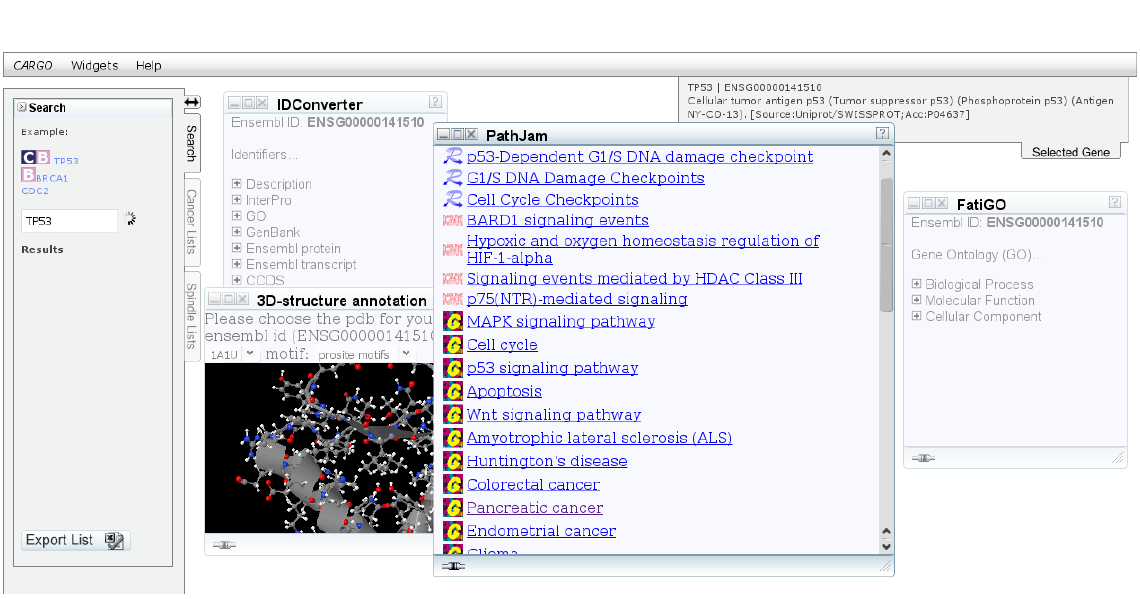
Figure 5: PathJam Widget for CARGO users showing information related with TP53